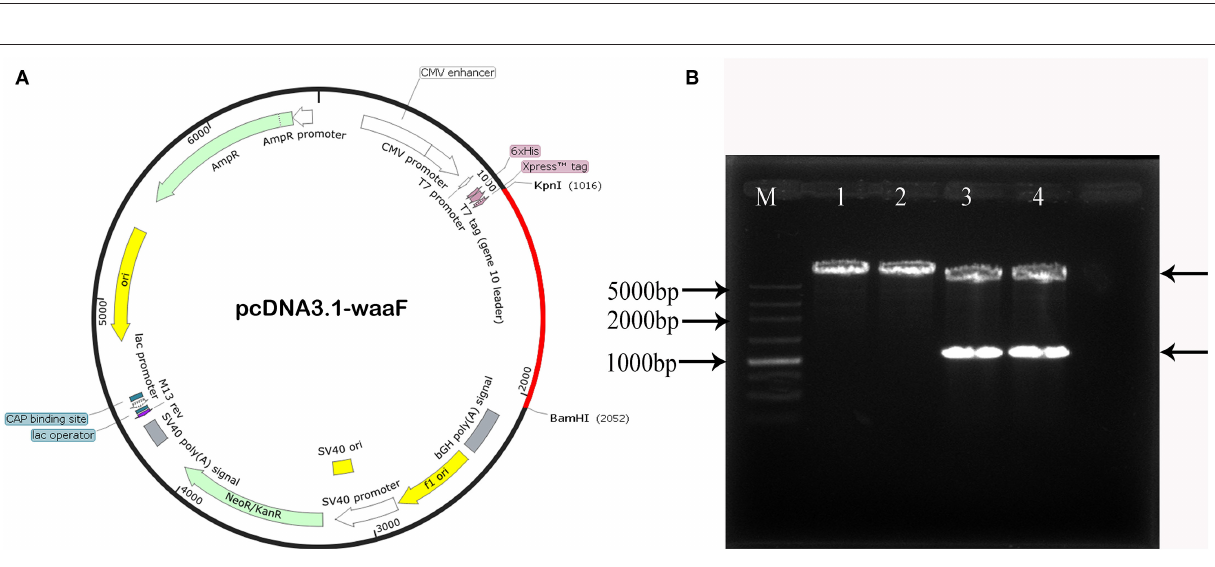
FIGURE 2 | (A) The new recombinant eukaryotic pcwaaF plasmid. The red part is the sequence of waaF genes inserted into the vector. (B) BamHI and Kpn I were digested the pcwaaF. Lane 1, 2 pcDNA 3.1- waaF plasmid; Lanes 3, 4 pcDNA 3. 1-waaF plasmid digested with BamH and Kpn I, and the band near 1,000 marker was waaF gene and the above band was pcDNA 3.1 plasmid; Lane M, 5,000